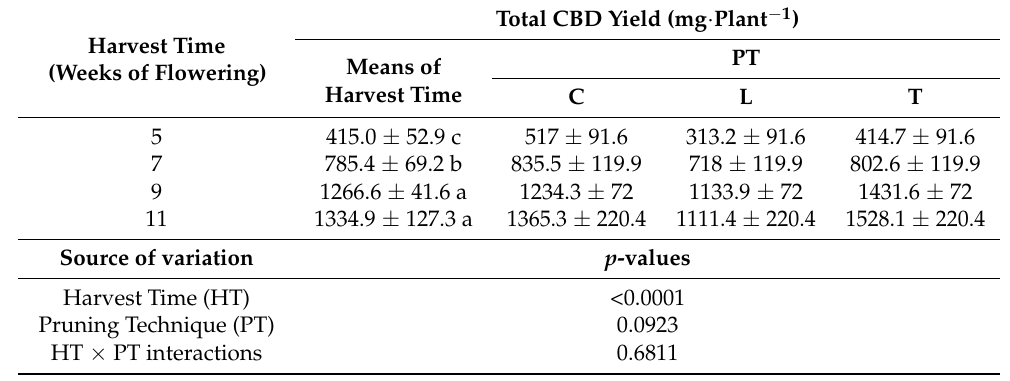
Table 3. Least square means ( ± standard error) of total CBD yield (mg · plant − 1 ) for the different harvest times (weeks of flowering) by each pruning technique (PT). Means of HT with at least one identical letter are not significantly different from each other according to Fisher ´ s LSD test with α = 0.05. Values for PT are not significantly different from each other according to global F-test. Pruning techniques (C—control; L—lollipop; T—topping). Note that p -values correspond to F-test within an ANOVA.